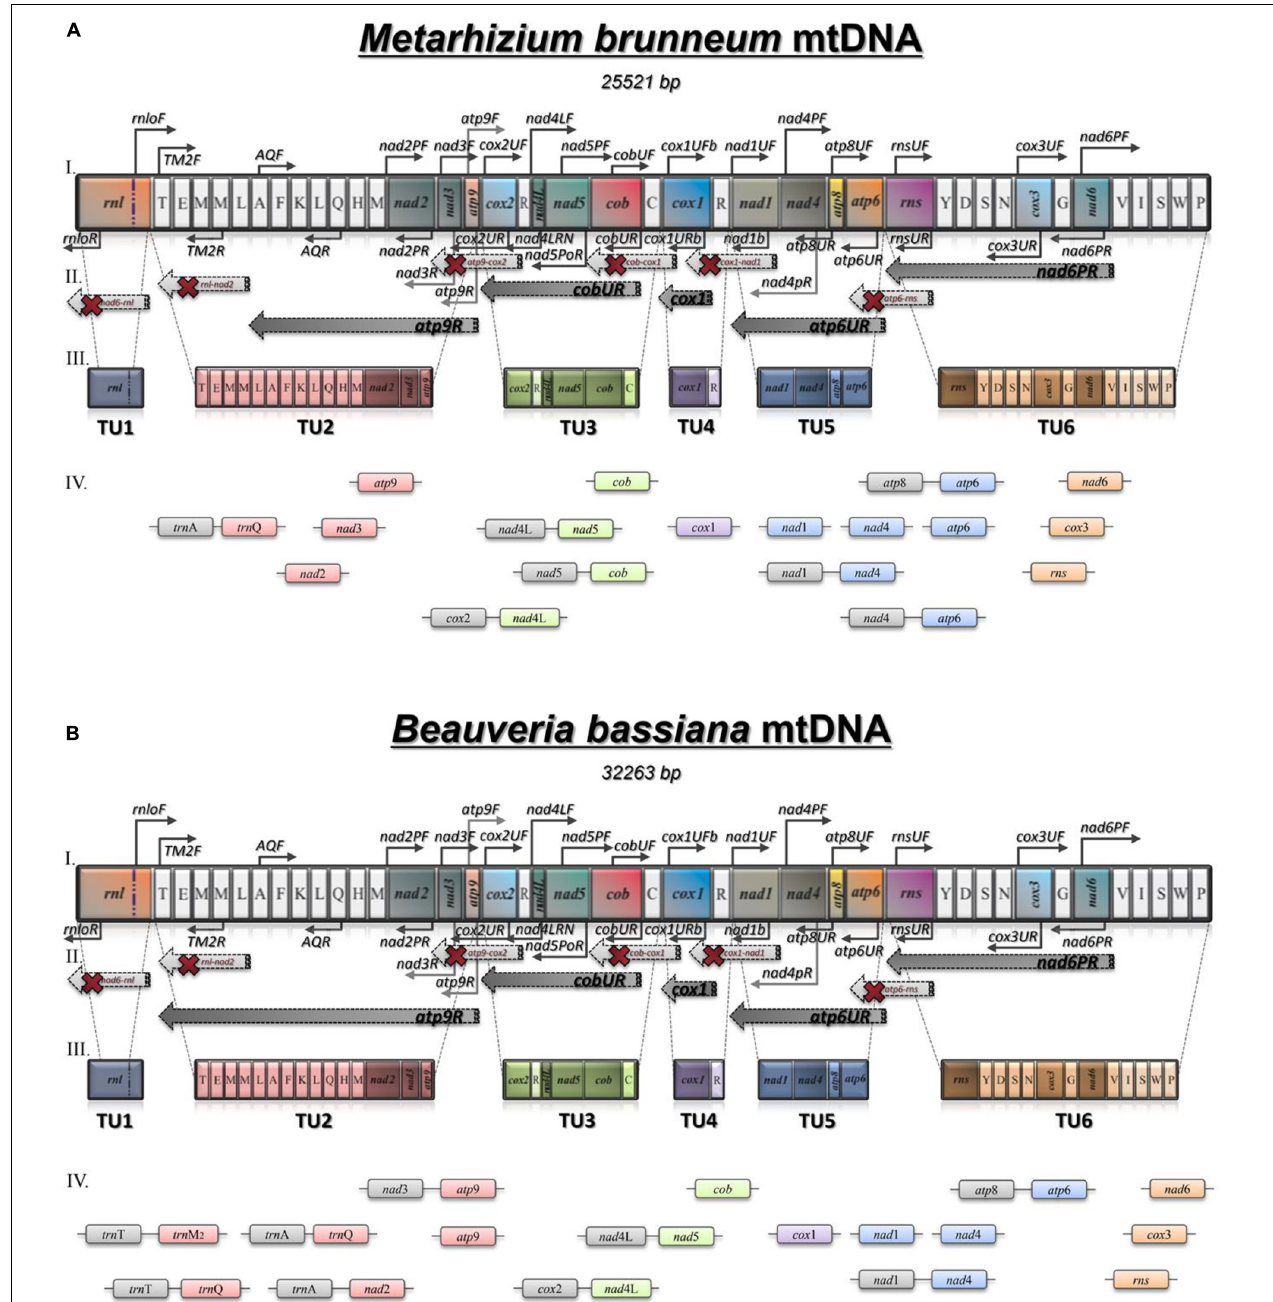
FIGURE 2 | The mt transcripts of M. brunneum (A) and B. bassiana (B) : Schematic representation of the strategy followed to determine transcripts for both species: (i) The synteny of the mt genome. Black arrows above and below the genes of the mt genome show the primers used for the RT- PCR experiments. (ii) Dark gray arrows represent the successfully obtained RT-PCR amplicons, while light gray arrows with a red “X” represent RT-PCR efforts with no result. (iii) The block of genes included in primary transcripts as acquired by Northern hybridizations. (iv) The amplicons obtained with RT-PCR.